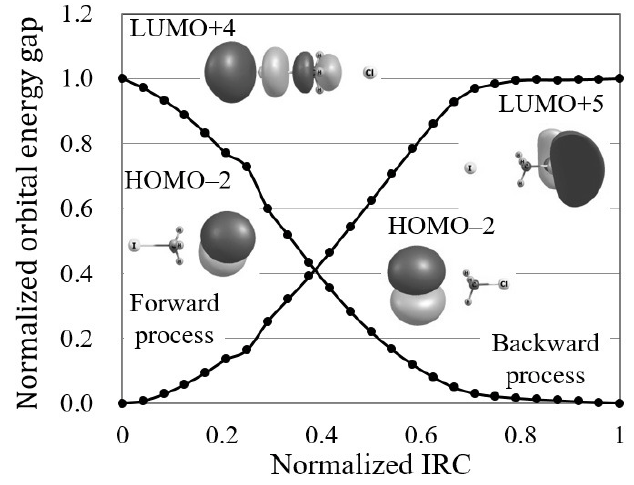
Figure 2. The normalized reaction diagram of the Cl − + CH 3 I → CH 3 Cl + I − reaction by LC-BOP/Def2-TZVPD calculation. The images of the molecular orbitals mainly contributing to each reaction process are also